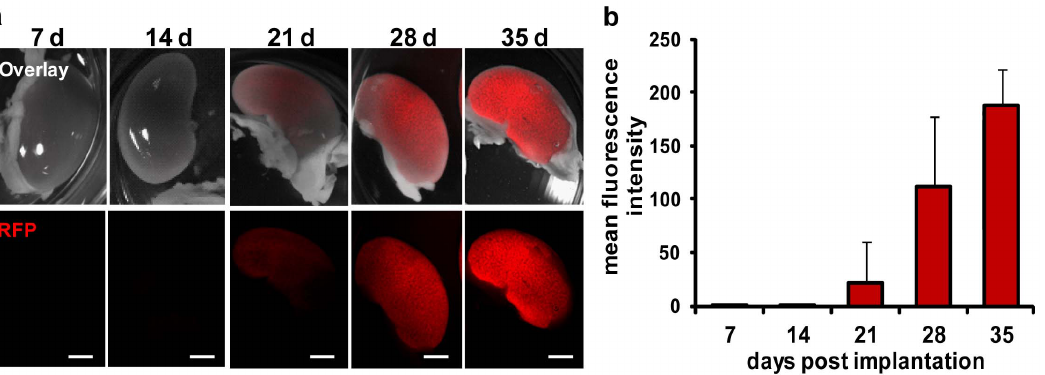
Figure 3. RFP signals in kidneys of C33A-RFP tumor-bearing mice 7, 14, 21, 28 and 35 dpti. Six to seven mice were analyzed per time point (7 and 21 dpti: n=7; 14, 28 and 35 dpti: n=6). a Representative images of RFP signal in kidneys. Upper row: overlay of bright field and RFP images. Lower row: images of RFP signal. Scale bars represent 2 mm. b Mean fluorescence intensity of the RFP signal in kidneys of C33A-RFP tumor- bearing mice over time.